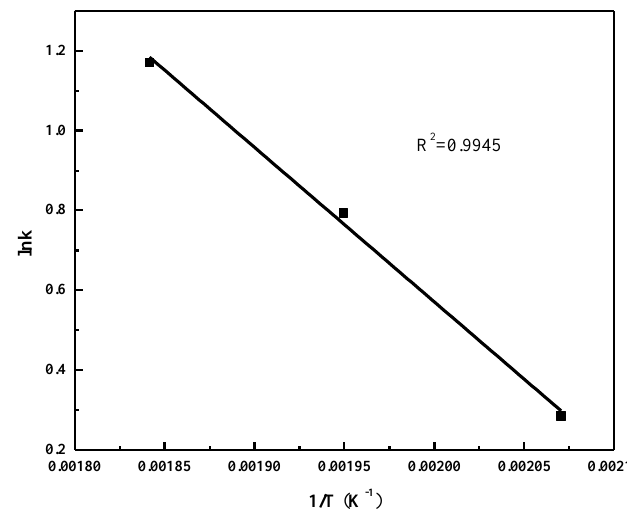
Figure 8. Arrhenius plot-based on Langmuir–Hinselwood (LH) model for FT synthesis over CoRu-MCM-41 catalyst.